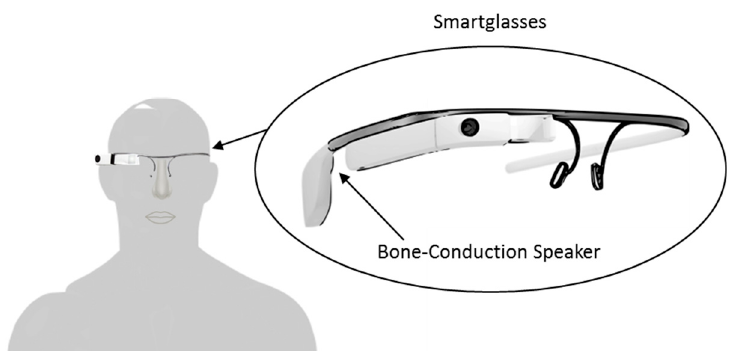
Figure 7. Illustration of the continuous auditory cueing system, used by Zhao et al. The Google ‘Glass’ system provided features such as monocular display and bone ‐ conduction sound. During auditory cueing the monocular display is clear and the bone ‐ conduction speaker delivers a burst of audio cueing at a set tempo.